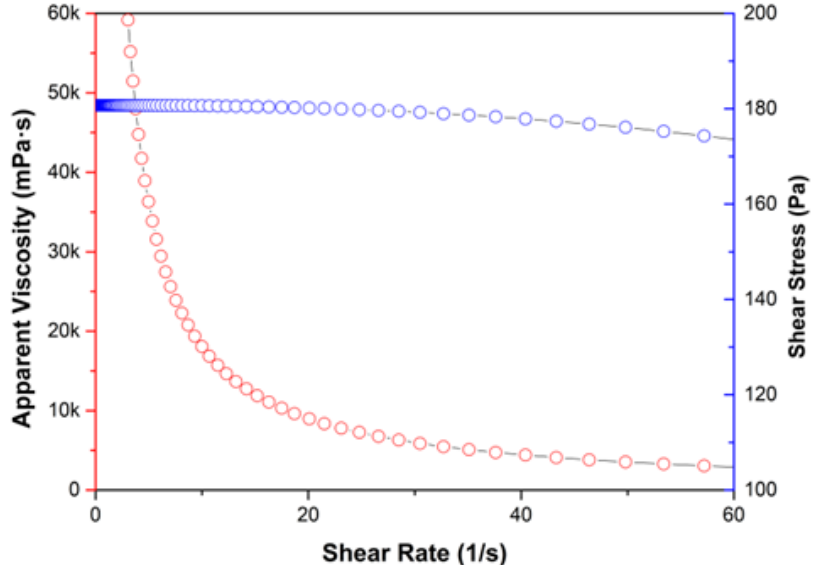
Figure 12. Apparent viscosity and shear stress vs. shear rate plot of the 3D printable sodium alginate gel (3D printing ink).